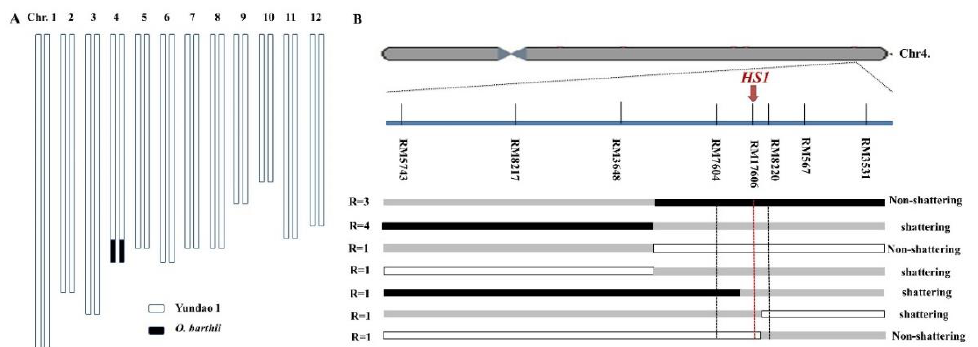
and pedicel junction in Yundao 1, F 1 hybrid and NIL- hs1 , respectively. ( B ) Yundao 1 showed an incomplete in abscission zone. ( C ) F 1 hybrid with a complete abscission layer. ( D ) NIL- hs1 exhibited a deficiency in abscission layer on the palea side and partial abscission layer on the lemma side. AL: Abscission layer, V: Vascular bundle. White arrow indicates a deficiency in abscission zone. Scale bars = 10 µ m.